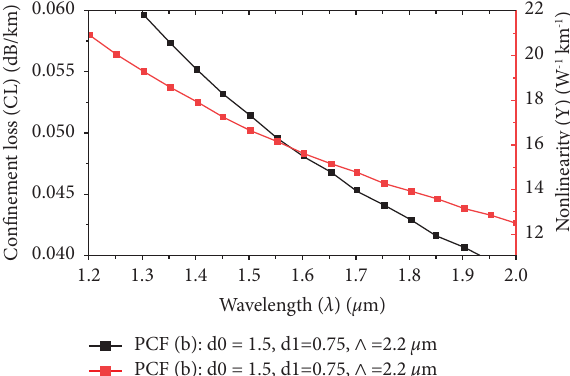
PCF (b): d0 = 1.5, d1=0.75, ∧ =2.2 μ m Figure 10: Plot of confnement loss against nonlinear coefcient as a function of variation in the wavelength for varied geometrical properties of PCF with 10 tiny air holes.